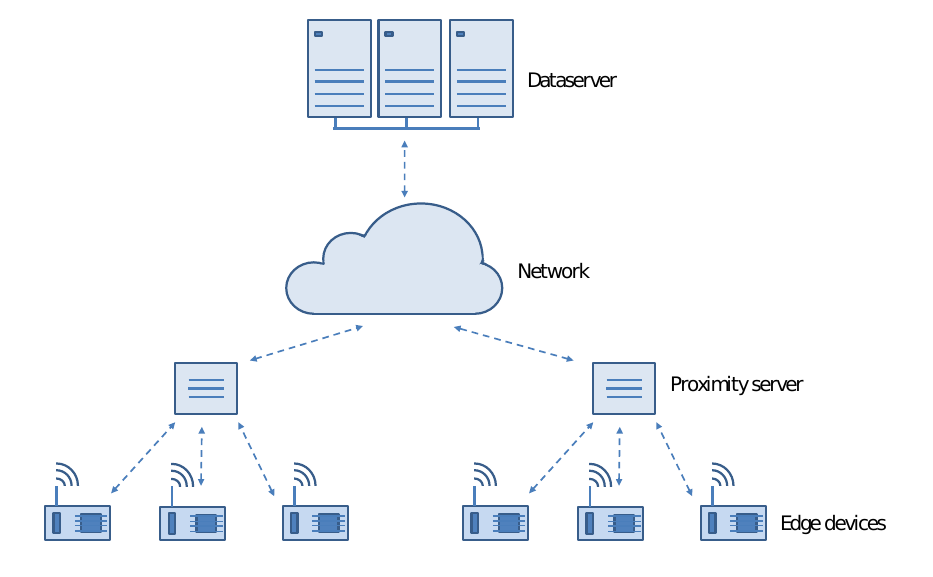
Figure 2. The basic edge computing